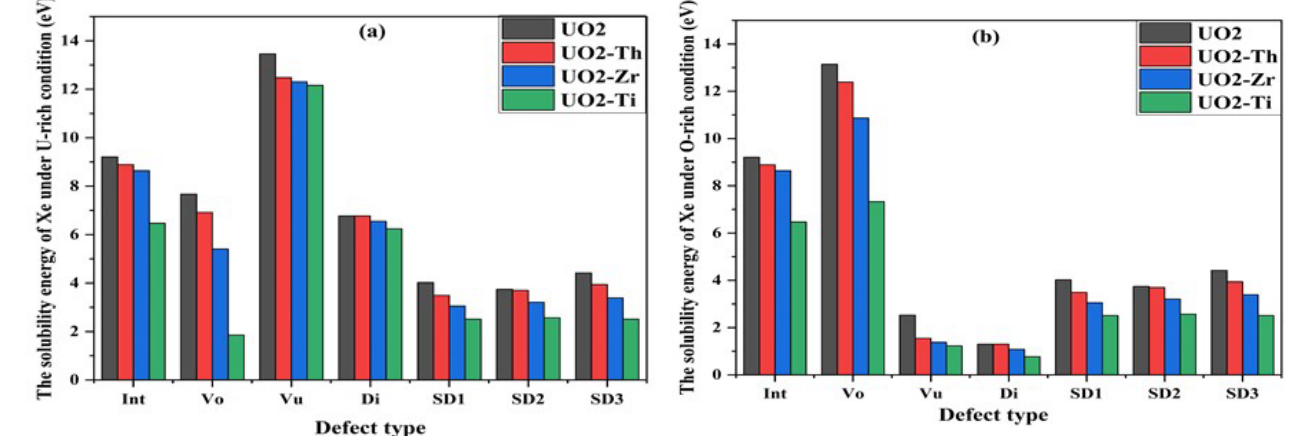
Figure 4. ( a ) Under the U-rich condition, the solution energy of Xe at different defect locations and the influence of dopants on it. ( b ) Under the Os-rich condition, the solution energy of Xe at different defect locations and the influence of dopants on it.